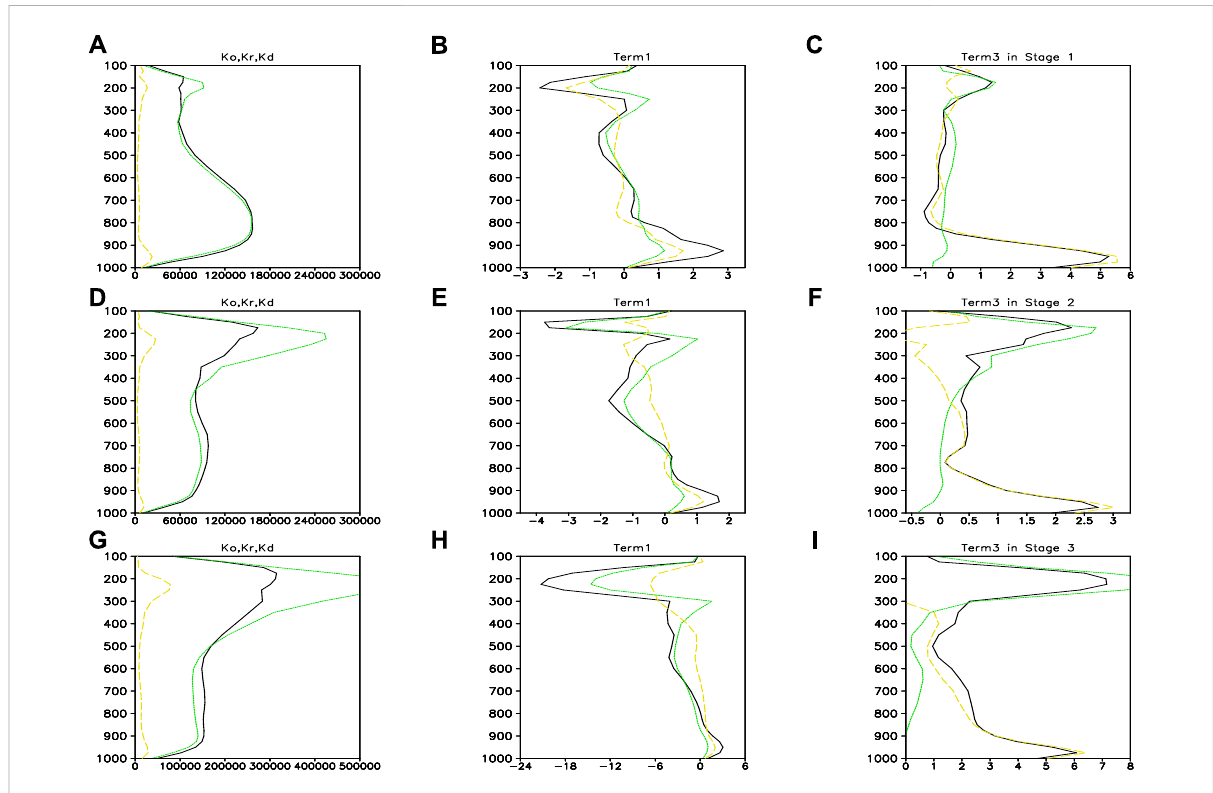
FIGURE 9 Same as Figures 7A – C but averaged over the pre-development stage (A – C) , the reintensi fi cation stages (D – F) and the ET stage (G – I)